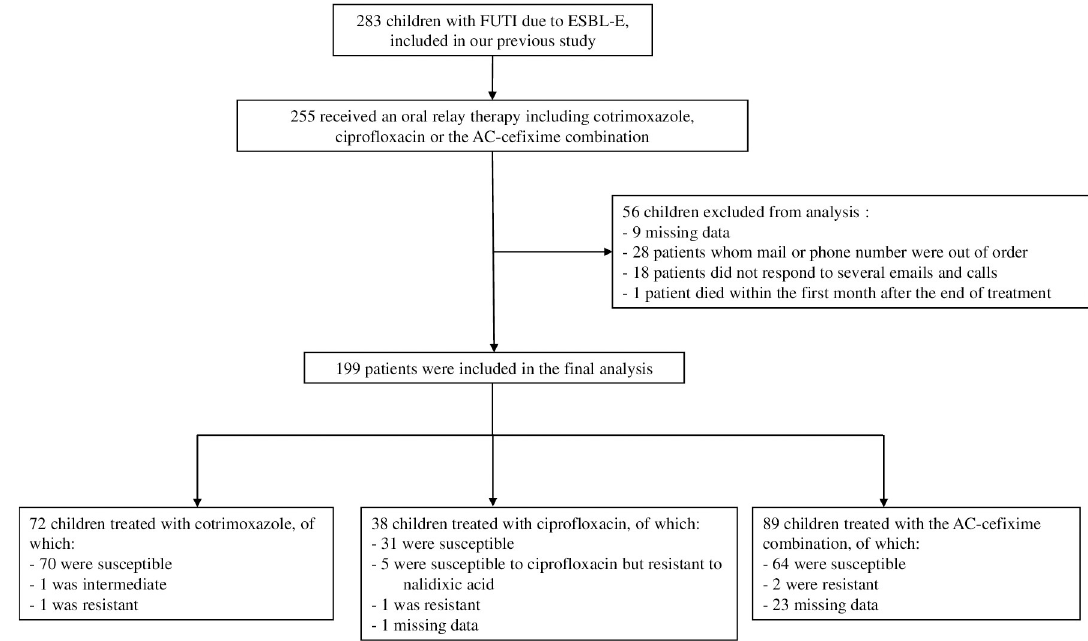
Fig 1. Study flow chart.